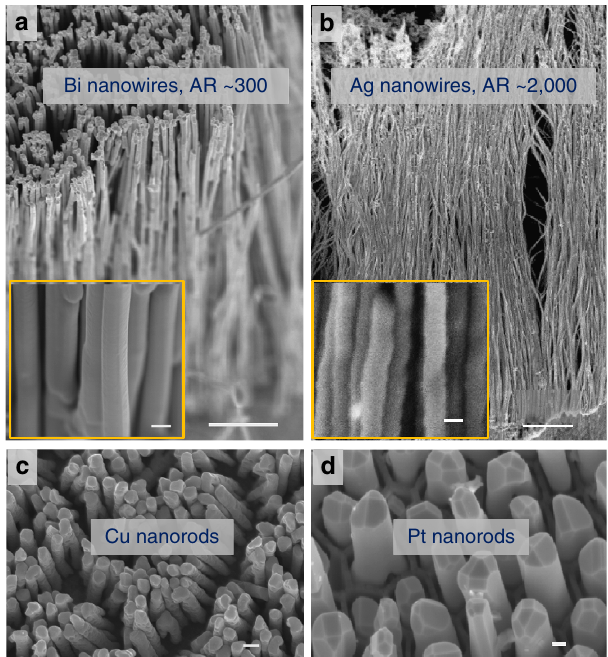
Figure 5 | SEM images of nanowire arrays. ( a ) SPNI a piece of Bi by using 200nm Al 2 O 3 template at 260 (cid:2) C (closing to its melting temperature, T m B 273 (cid:2) C) and under a force of 8kN. Bulk Bi completely filled the Al template within 36s, corresponding to an aspect ratio of B 300 since the thickness of Al 2 O 3 template is B 60 m m. Scale bar, 5 m m. Inset figure scale bar, 200nm. ( b ) An extremely high-aspect ratio of B 2,000 for Ag nanowires was also obtained by SPNI of a piece of Ag into 25nm Al 2 O 3 template at B 700 (cid:2) C, under an applied force of 15kN and holding for 90min. Scale bar, 2 m m. Inset figure scale bar, 25nm. ( c , d ) Cu and Pt nanowire arrays were fabricated by SPNI at B 550 and B 820 (cid:2) C, respectively. Scale bars, 200 and 100nm,